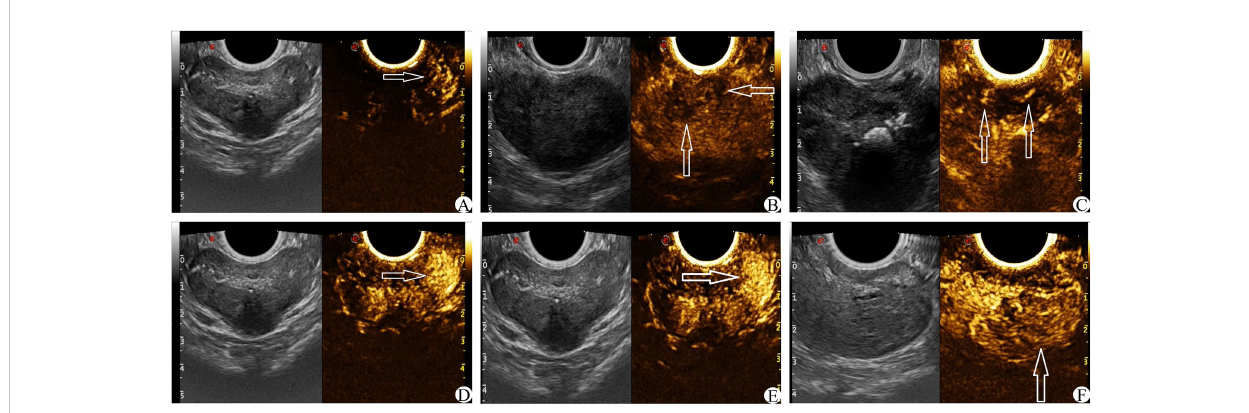
FIGURE 4 CEUS score (white arrow) (A) : The arrival time of contrast media in the left lesion was earlier than that in the contralateral side. (B) The enhancement was uneven and the boundary was not clear. (C) Enhance the asymmetric vascular structure in the lesion. (D) The peak intensity of the left lesion was higher than that of the contralateral lesion. (E) The enhanced boundary of the left lesion was clear. (F) The clearance time of the contrast agent in the lesion was shorter than that of surrounding normal tissue.